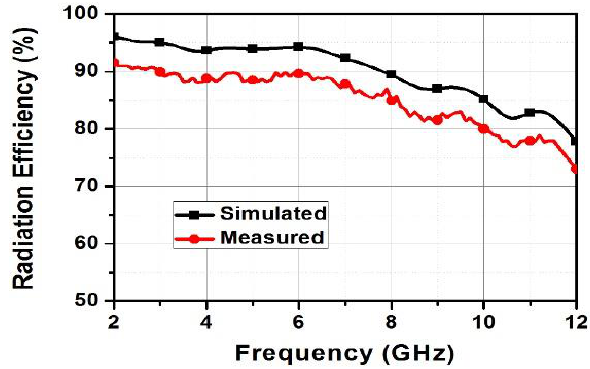
Figure 28. Radiation efficiency of the sensing antenna.